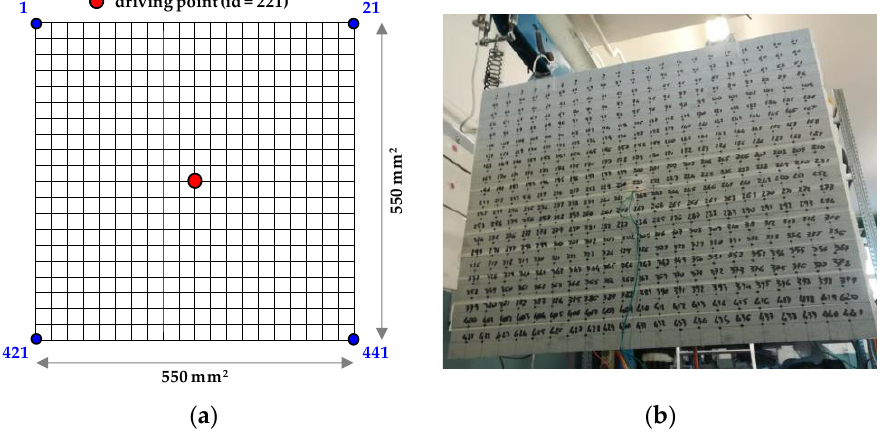
Figure 1. Discretization of composite panel in 441 grid points: ( a ) mesh with details of size and driving point; ( b ) acquisition mesh for laser vibrometry test.